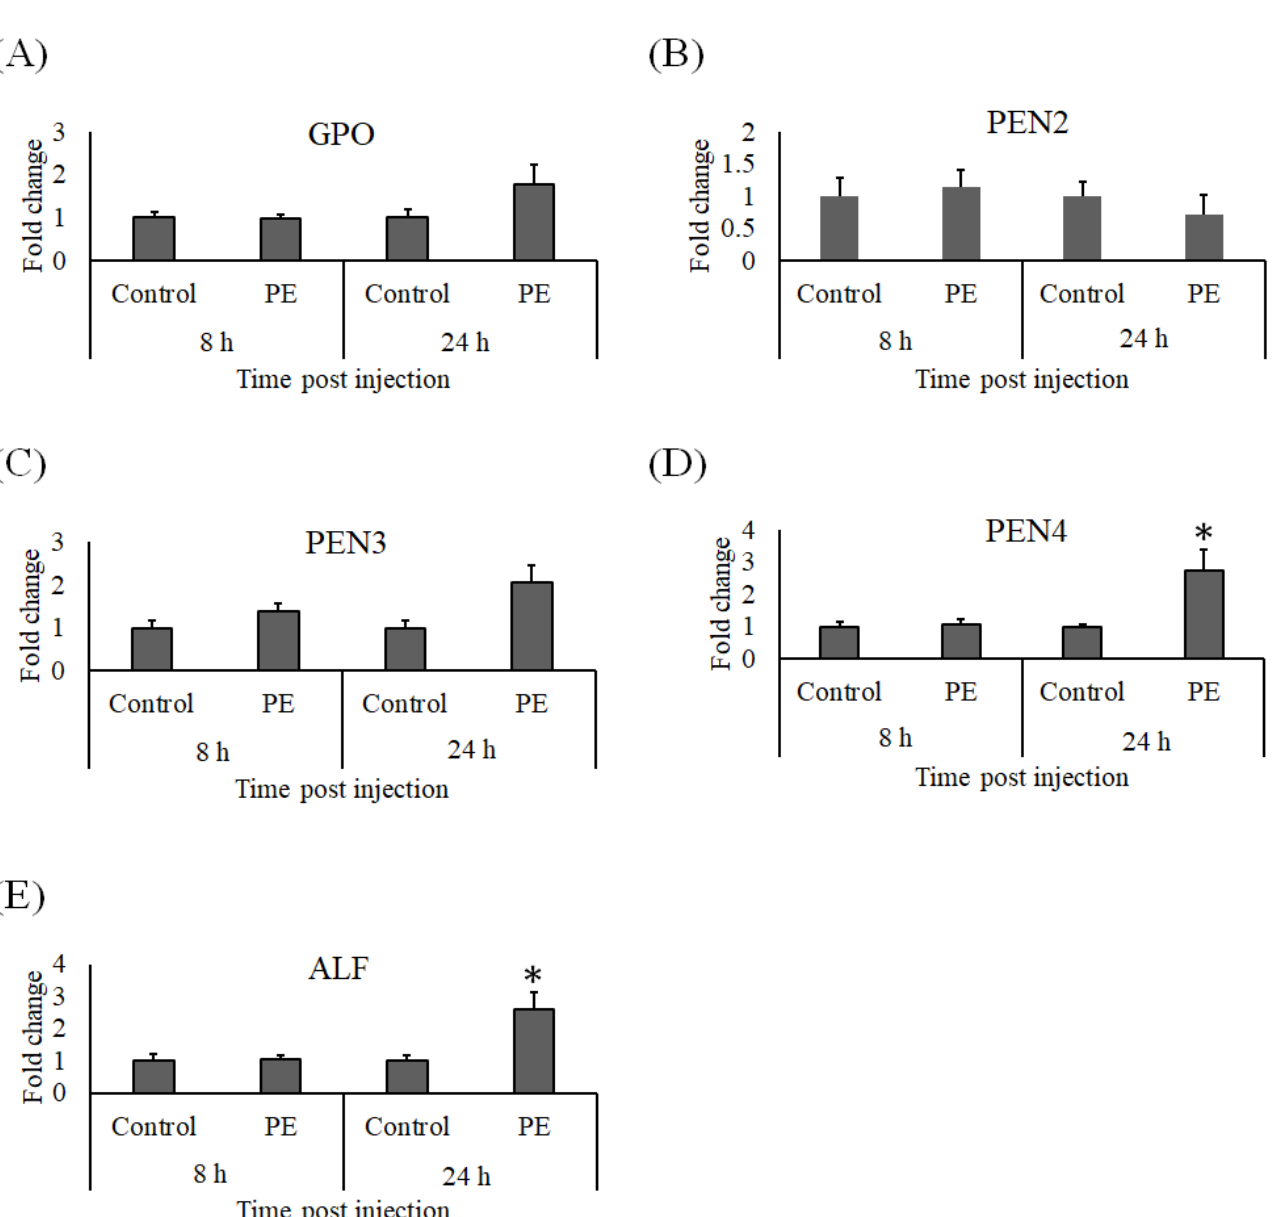
Figure 9. Gene expression of ( A ) GPO , ( B ) PEN2 , ( C ) PEN3 , ( D ) PEN4 and ( E ) ALF in hemocytes from whiteleg shrimp ( Litopenaeus vannamei ) injected with 0.30 µ g of phycoerythrin (PE) per gram of whiteleg shrimp body weight or vehicle alone (control). After 8 and 24 h of stimulation, the relative expression levels of immune genes were normalized to the transcript level of EF1 α and presented as a fold change relative to the control group. Data are expressed as the mean ± standard error of the mean ( n = 5) and significant differences from the control group are denoted by asterisks ( p < 0.05, paired sample t -test).